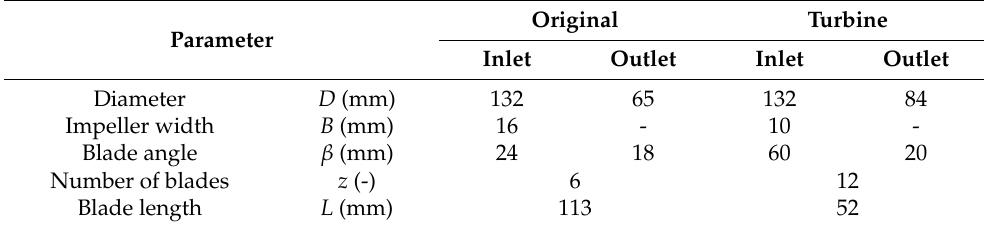
Table 1. Overview of the impellers’